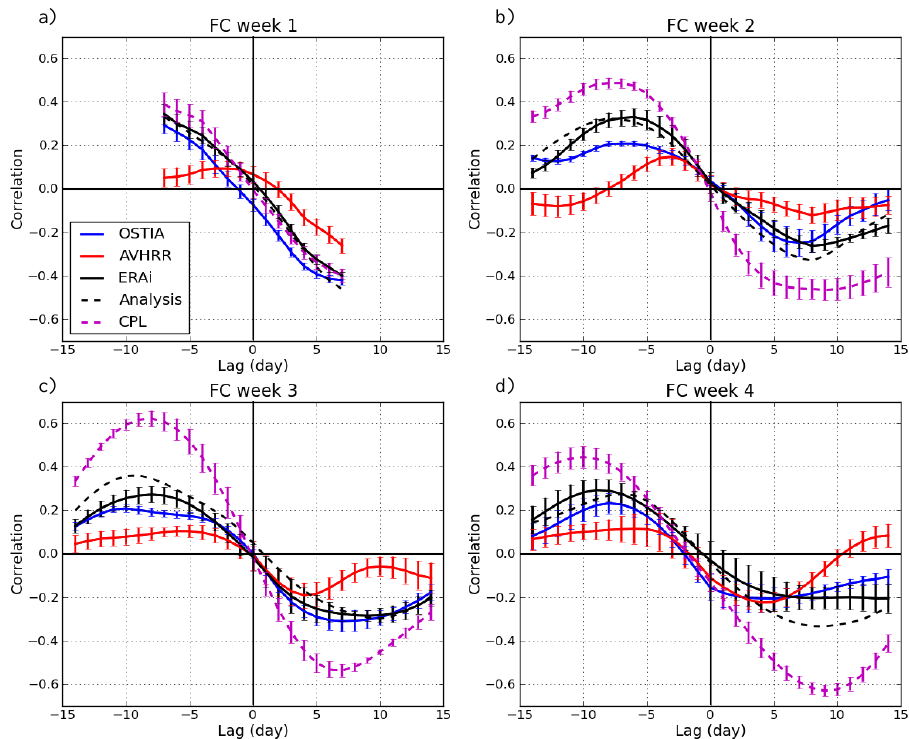
Fig. 8. Lag correlation coefficient between OLR and SST anomalies over the region 5 ◦ S–5 ◦ N, 60 ◦ –95 ◦ E averaged according to the forecast week of the experiments conducted over 22 winters (1985–2006). OSTIA, AVHRR and ERAi experiments are the blue, red and solid black lines, respectively. Their equivalent in the ERA interim reanalysis is the black dashed line. For comparative purposes, the coupled experiment is plotted in dashed purple. (a) Week 1, (b) 2, (c) 3 and (d) 4. Error bars stand for the ensemble spread.